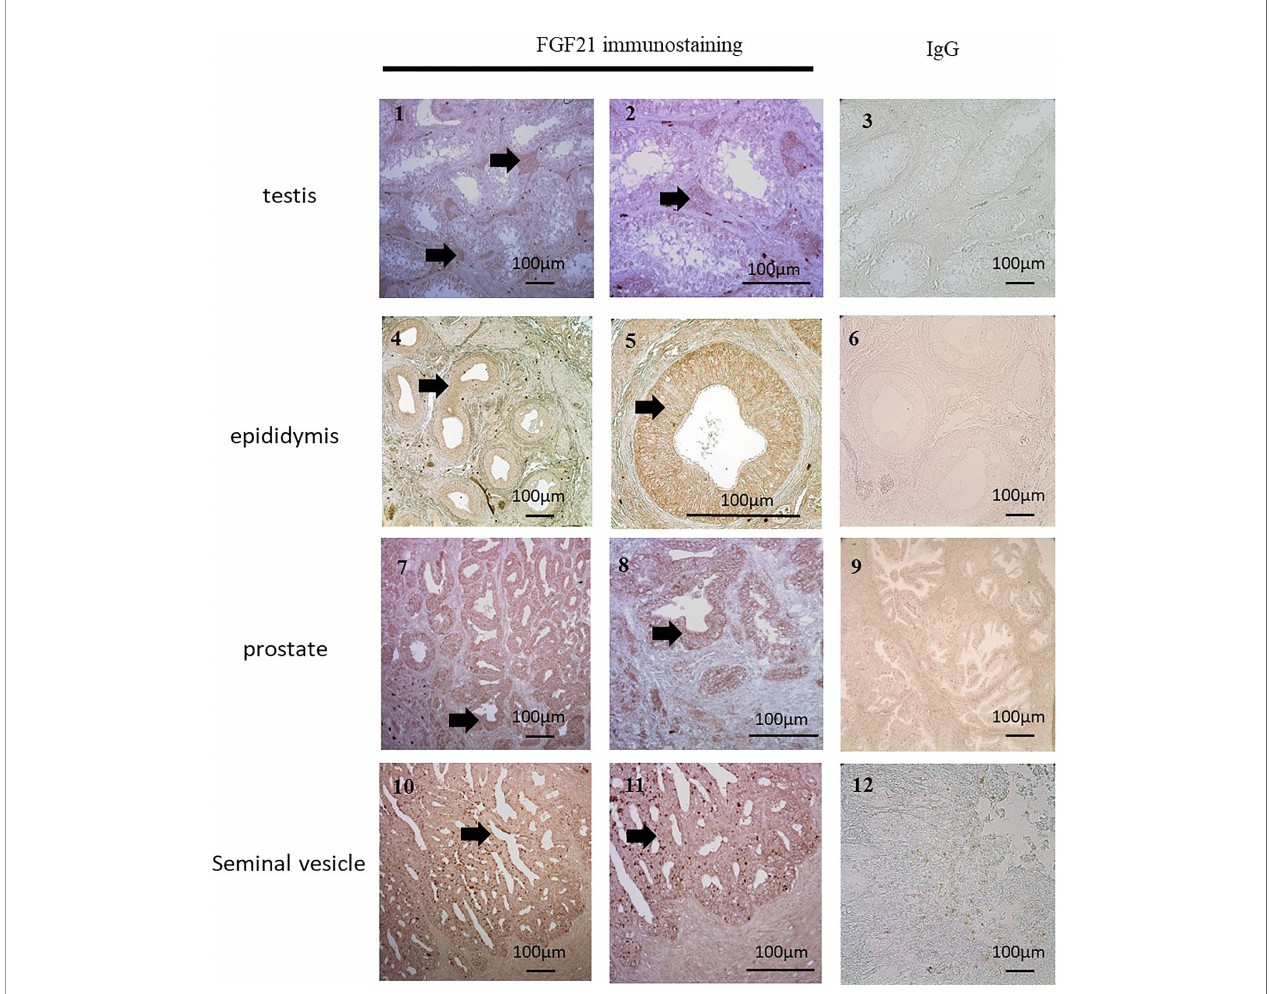
FIGURE 2 | Localization of FGF21 in reproductive organs. FGF21 was localized by immunohistochemical staining in human testis (1 and 2), epididymis (4 and 5), seminal vesicles (7 and 8) and prostate (10 and 11). Negative controls (3, 6, 9, and 12) were sections incubated with IgG. We observed FGF21 expression in Leydig cells and the epithelia of the epididymis, prostate and seminal vesicles (see arrow), which contained all secretory